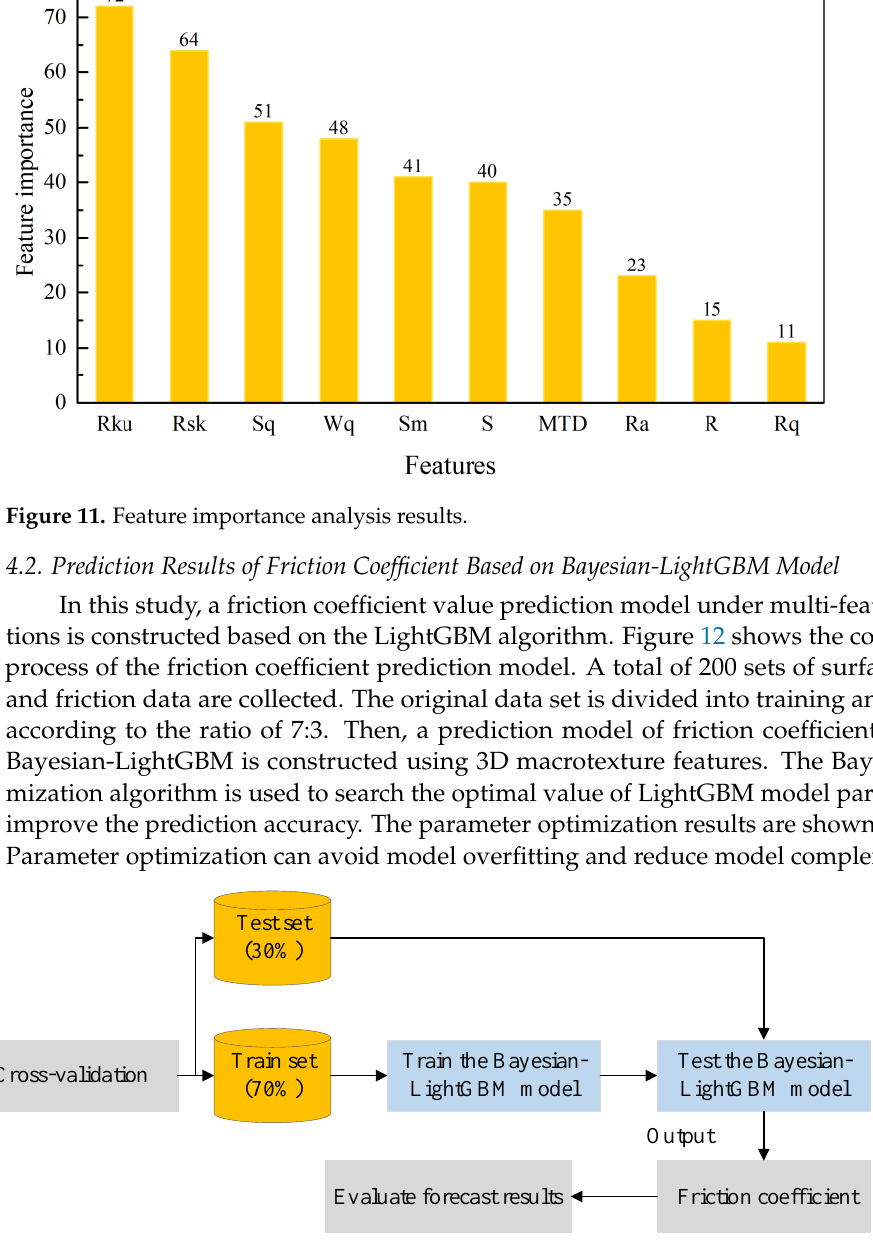
Figure 12. Friction coefficient prediction model based on LightGBM algorithm. Table 5. Parameter optimization results.